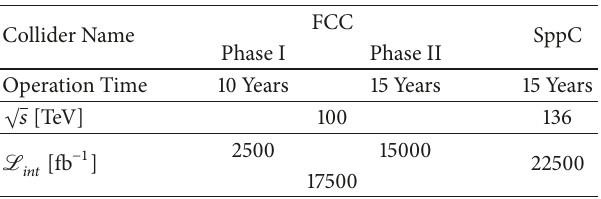
Table 1: Planned operation time of FCC and SppC and their main